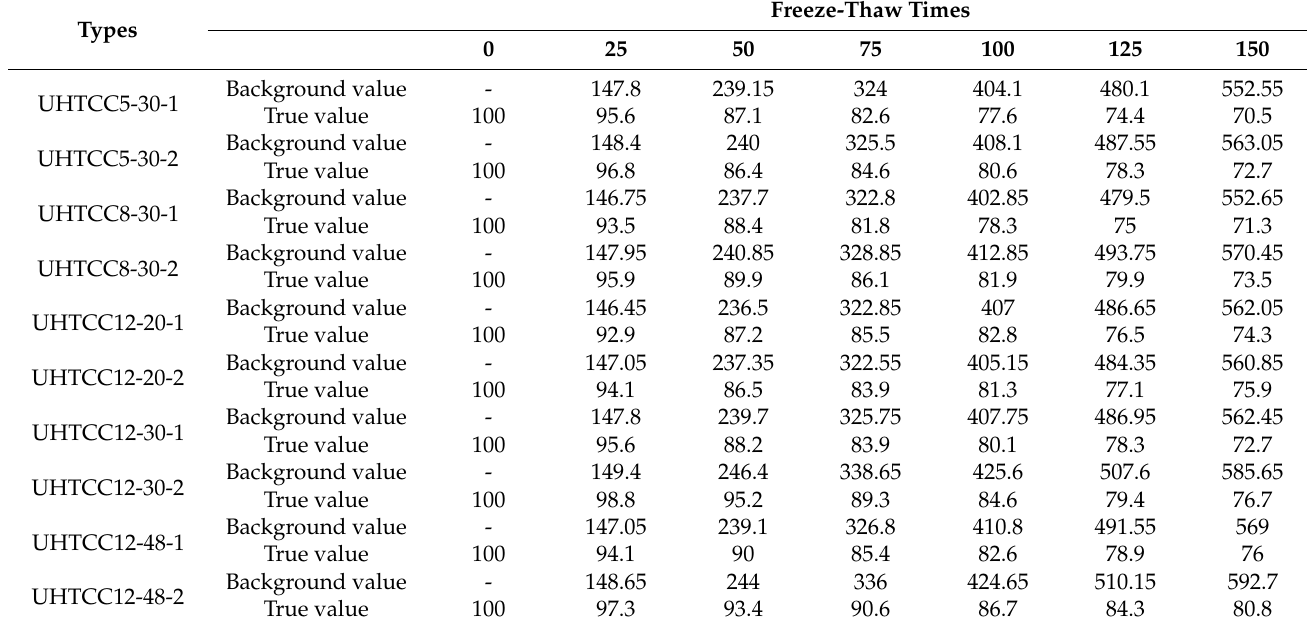
Table 6. Background value of the UHTCC relative dynamic elastic modulus.